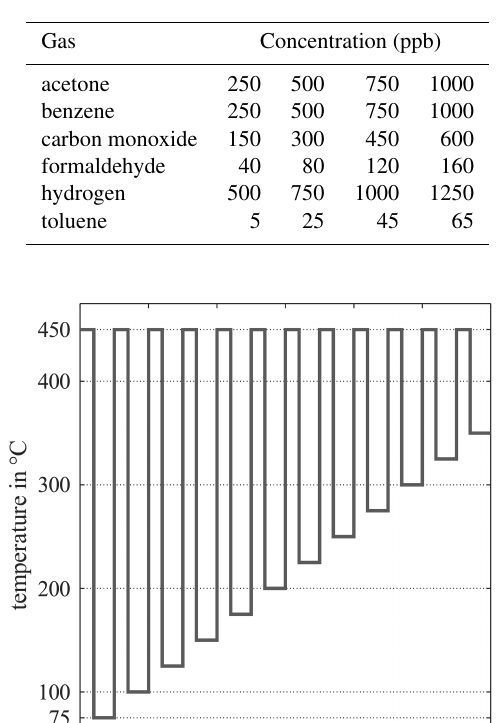
Table 3. Gas concentrations used for the sequential calibration.